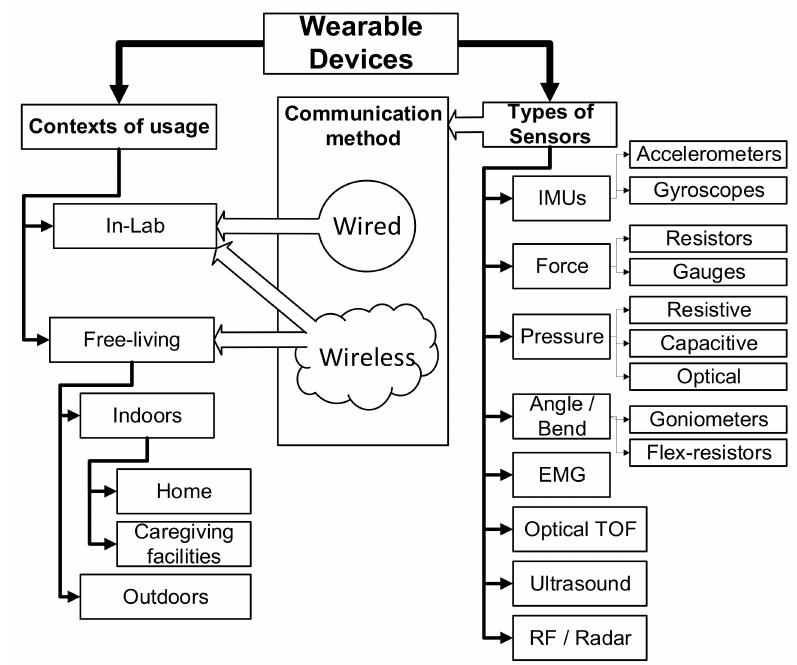
Figure 3. Classification of Wearable Devices. This classification shows how the different types of sensors can be used in different contexts depending on the communication method. TOF stands for time-of-flight, EMG for electromyography and IMUs for inertia measurement units.